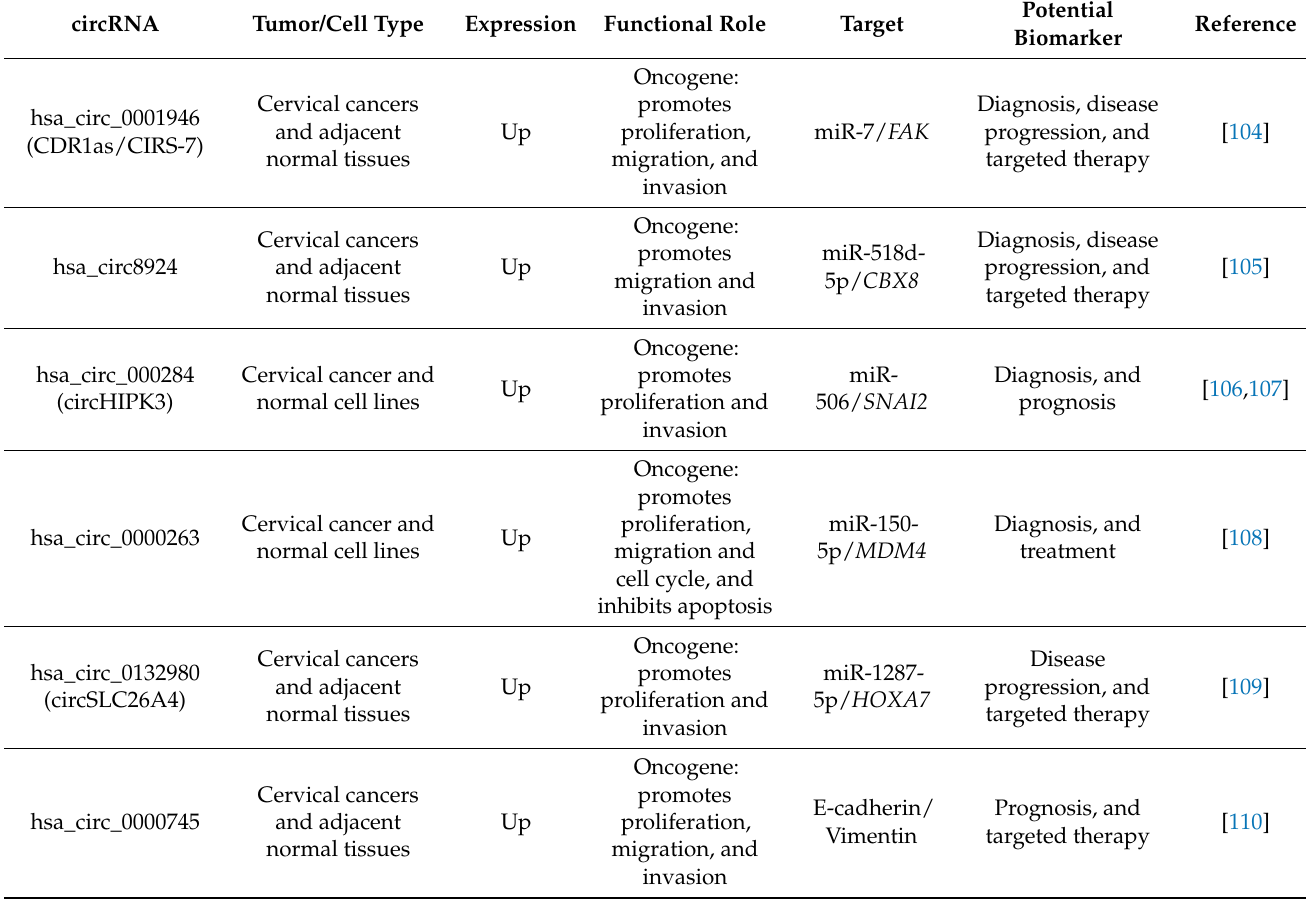
Table 1. Tumor and/or cell type, expression, functional role, target, and potential use as biomarkers of circRNAs of HPV-associated